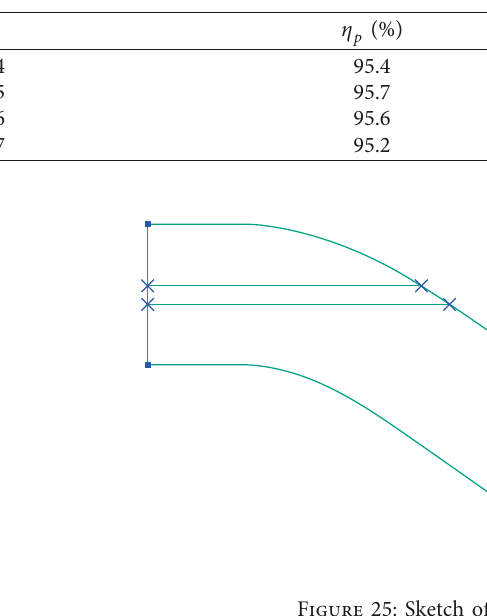
Figure 24: Minimum cavitation number C p min with different dip angles. Table 6: Evaluation index of inlet passage.